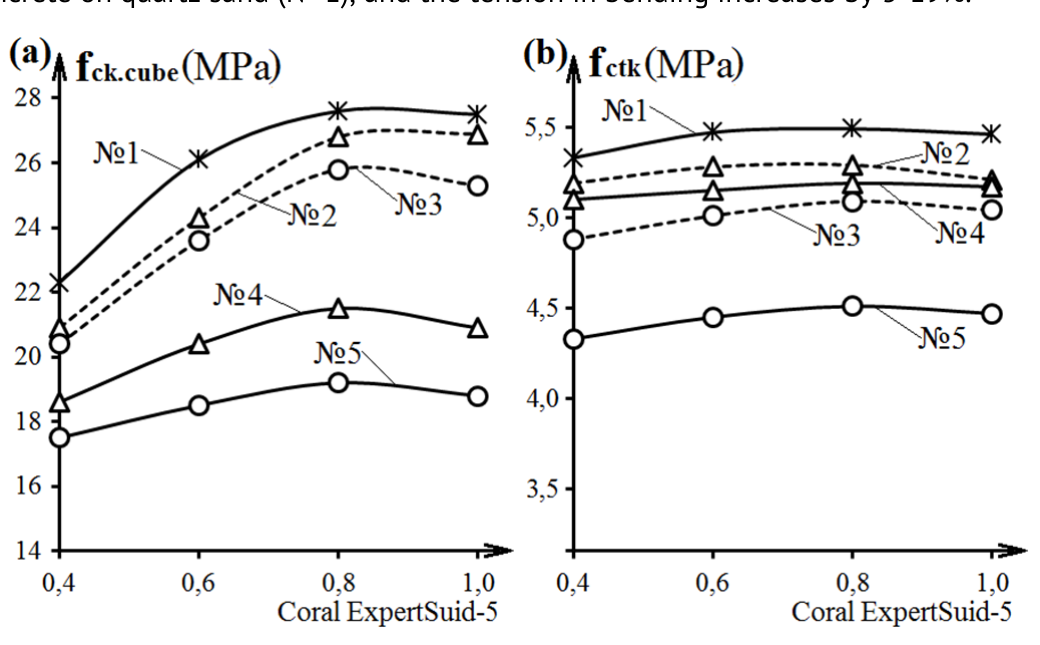
Figure 2. The effect of the amount of plasticizer and the type of sand on the strength of expanded clay lightweight concrete: a) in compression; b) tension in